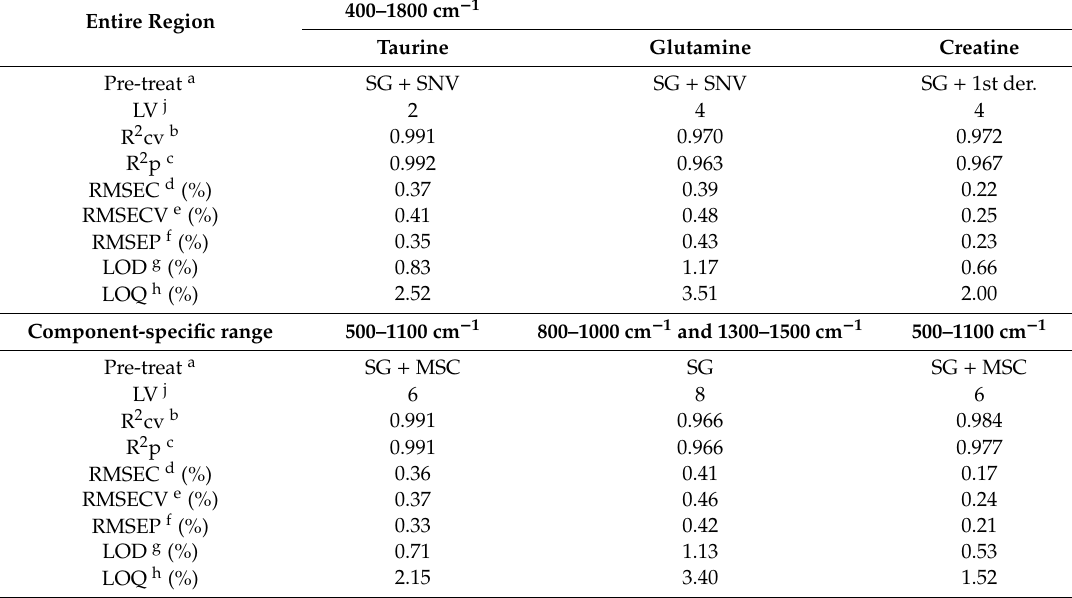
Table 3. Partial least squares regression (PLSR) results for three adulterate concentrations in different spectralregions. a isthepretreatmentmethodused; b referstodeterminationcoefficientofcross-validation; c is the determination coefficient of prediction; d represents the room mean square error of calibration; e is the room mean square error of cross-validation; f is the room mean square error of prediction; g and h are limit of detection and limit of quantification; j is the number of latent